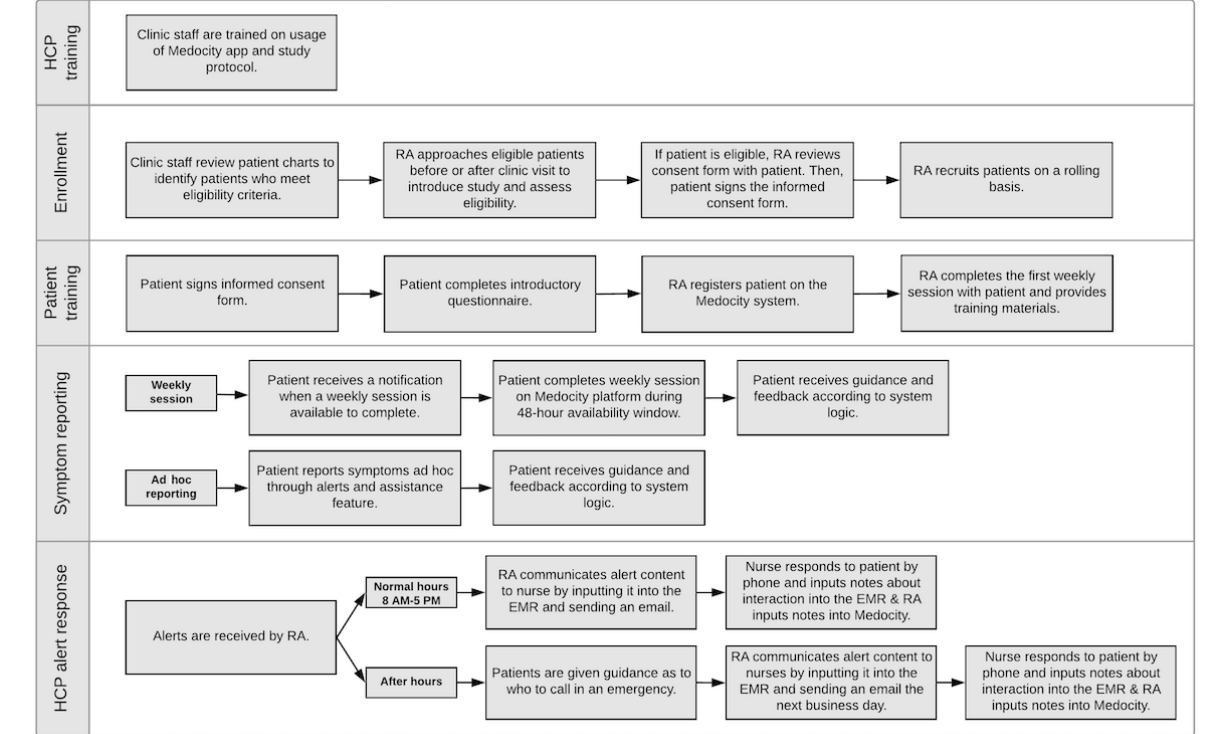
Figure 2. Planned study workflow. EMR: electronic medical record; HCP: health care professional; RA: research assistant.